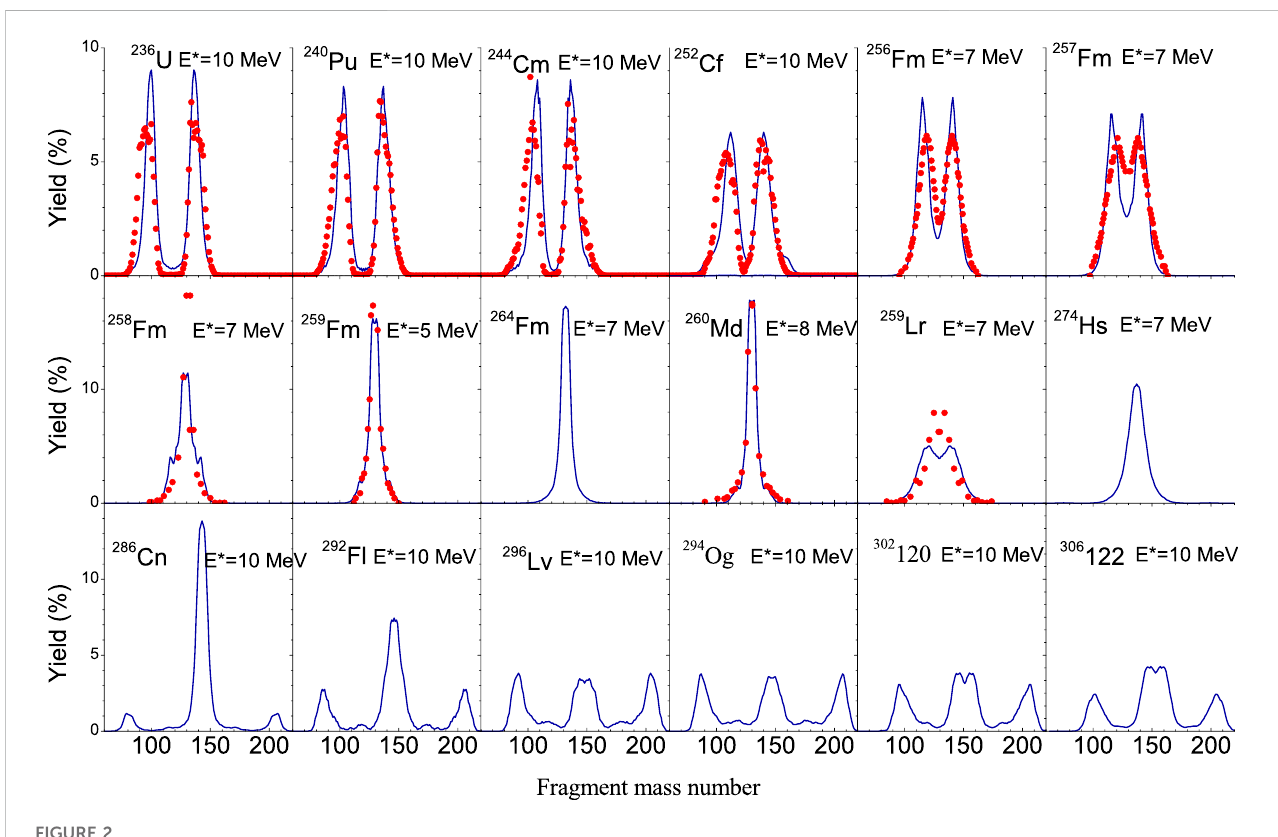
FIGURE 2 Calculated fi ssion fragment mass distributions of 236 U to 306 122 (blue) and the available experimental data (red points) for the thermal neutrons induced fi ssion of 235 U - 252 Cf after prompt neutron emissions JENDL/FPY-2011 [34] and for spontaneous fi ssion of 256 Fm - 259 Lr [35 –